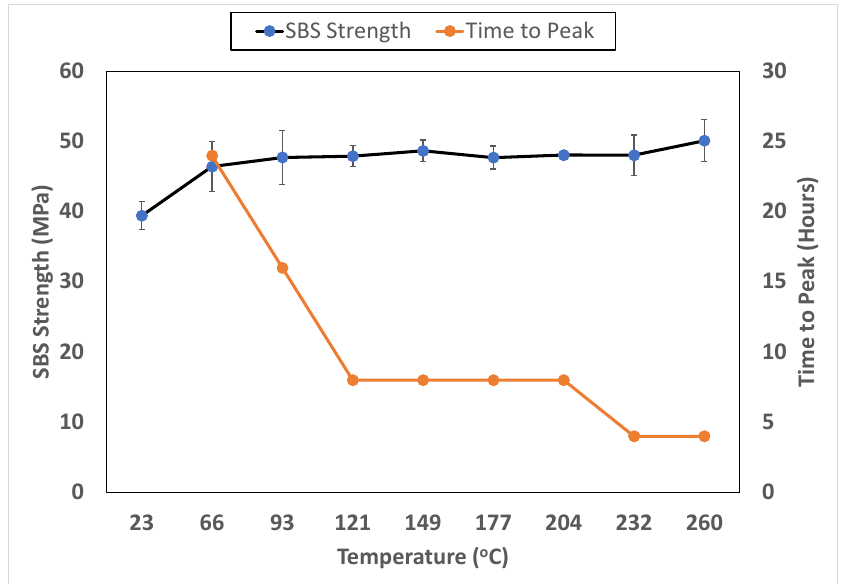
Figure 6. Comparison of peak SBS strength and time to attain the peak as a function of temperature of thermal aging.